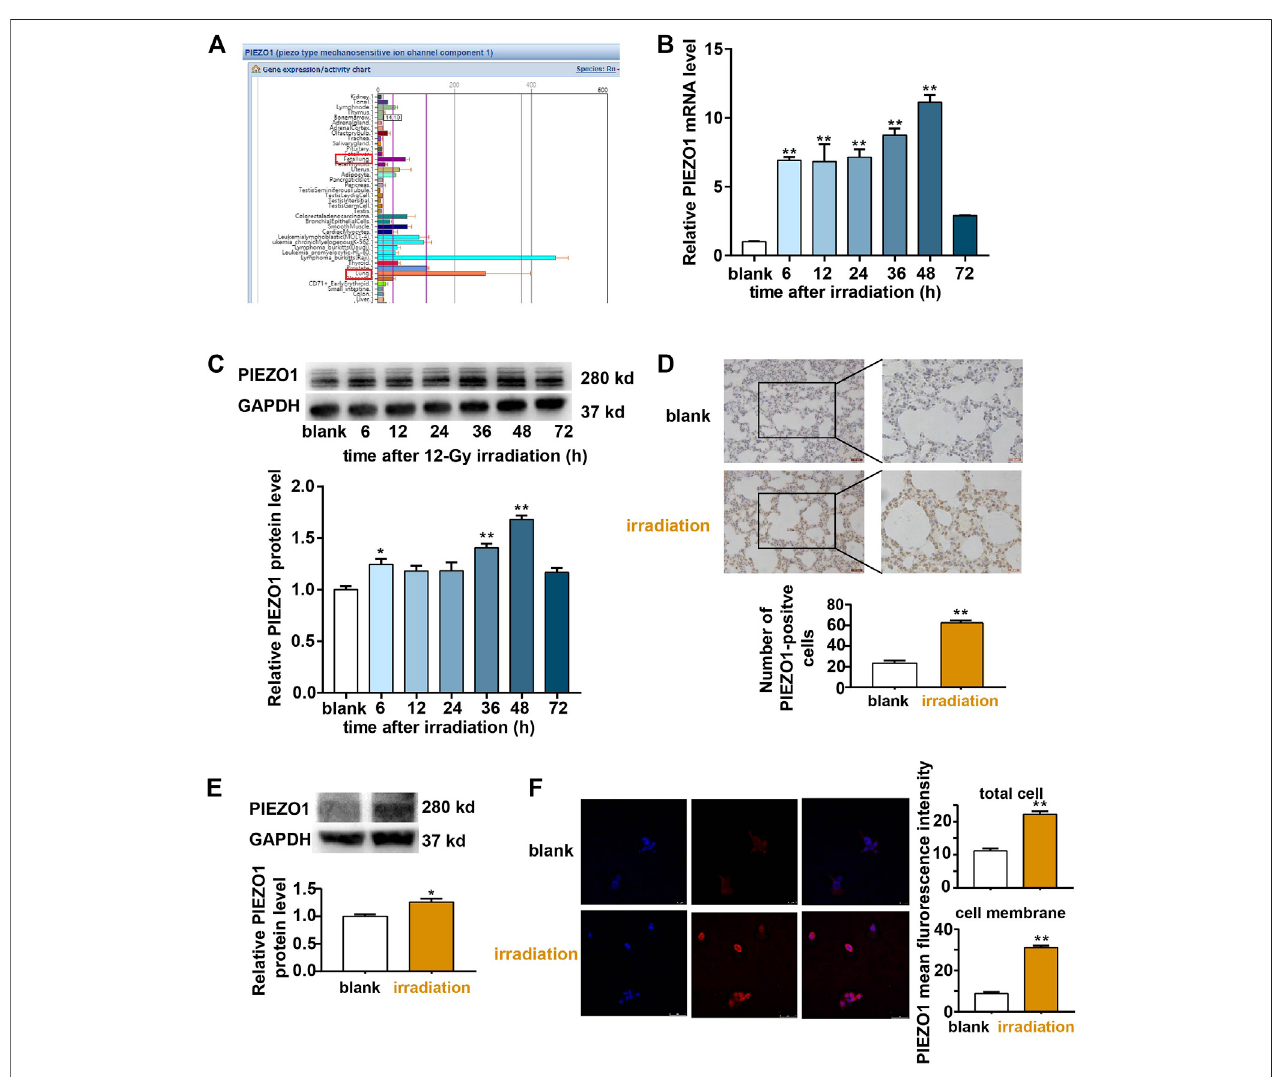
FIGURE1| PIEZO1expressionwasupregulatedafterirradiation(IR). (A) BioGPSdatabasedemonstratedthatPIEZO1iswidelyexpressedinvariouskindsoflung. (B) PIEZO1mRNAexpressionwasincreasedinRLE-6TN cellsafterirradiation. (C) RepresentativeWesternblottingimagesandhistogramsshowedthatPIEZO1protein expression was increased 48 h after irradiation (IR). (D) Immunohistochemistry studies revealed that PIEZO1 expression was upregulated in rat lung epithelial cells 48 h after irradiation. The cell nucleus was stained with hematoxylin (blue) and PIEZO1 protein was stained using speci fi c antibody with the DAB nickel method (dark brown). (E) Western blotting showed PIEZO1 protein expression in rat lung tissue expression was increased 48 h after irradiation (F) Immuno fl uorescence staining showed that PIEZO1 expression was upregulated in the cell membrane and total part of RLE-6TN cells 48 h after irradiation. Nuclei were stained with DAPI (blue). Data are presented with the means ± SEMs (n (cid:2) 3). *, p < 0.05; and **, p <